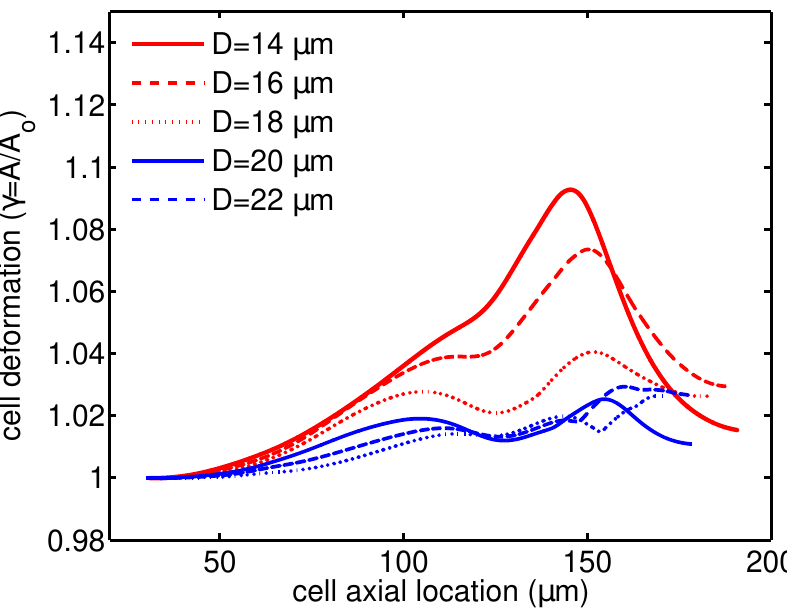
Figure 6. Deformation of an HL60 cell for different radii of encapsulating droplet at λ = 0.1s, β = 0.5, Ca = 0.00076 and Re =